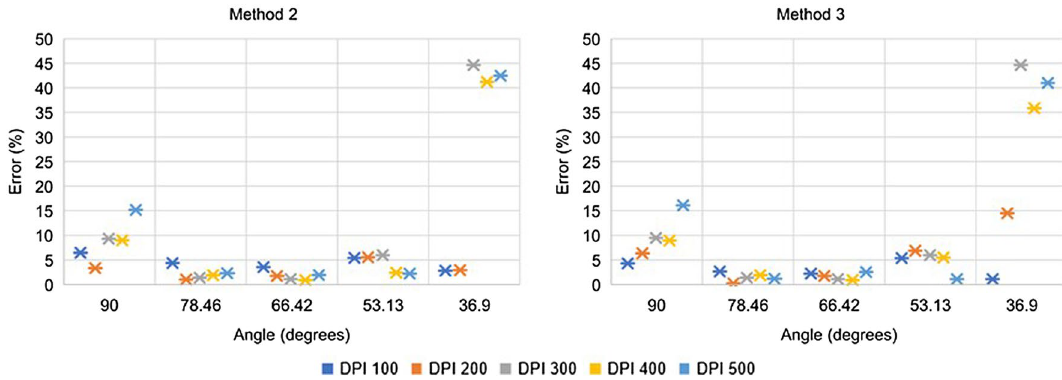
Fig. 6 Error percentage for five DPI values for Methods 2 and 3 only Fig. 7 Image processing of the X-ray image by using Method 2 in Fig. 4